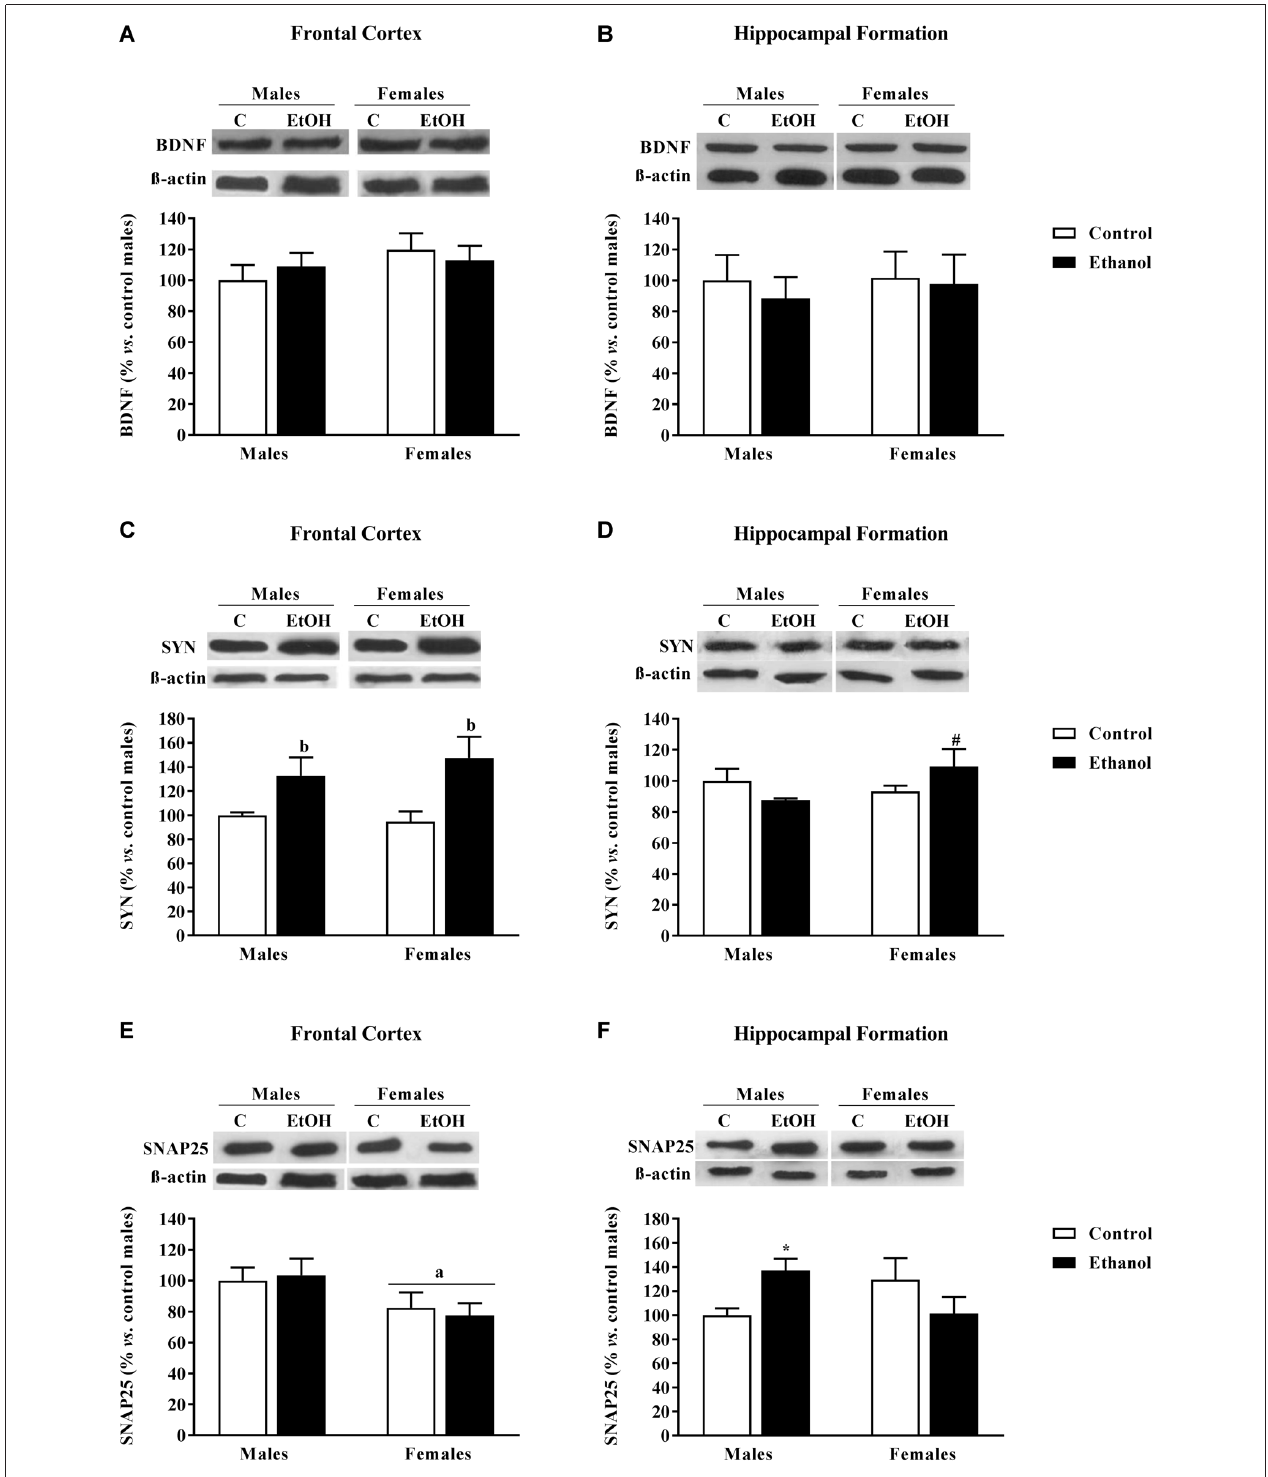
FIGURE 6 | Expression of some markers of synaptic plasticity. Protein expression levels of (A,B) brain derived neurotrophic factor (BDNF); (C,D) synaptophysin (SYN); and (E,F) SNAP25 within the frontal cortex (left panels, A,C,E ) and the Hippocampal Formation (right panels, B,D,F ) of adult male and female rats that were exposed to ethanol (20% in drinking water) or tap water for 2-h sessions during 3 days, and for an additional 4-h session on the 4th day, every week during adolescence, from postnatal days (pnd) 28–52. Histograms (mean ± SEM) represent the protein levels expressed as values of optical density calculated as changes from the control male group (%). ANOVA, a p < 0.05 general effect of sex; b p < 0.05 general effect of treatment. ∗ p < 0.05 vs. control male; # p < 0.05 vs. control female. n = 6 per experimental group, coming from four litters.